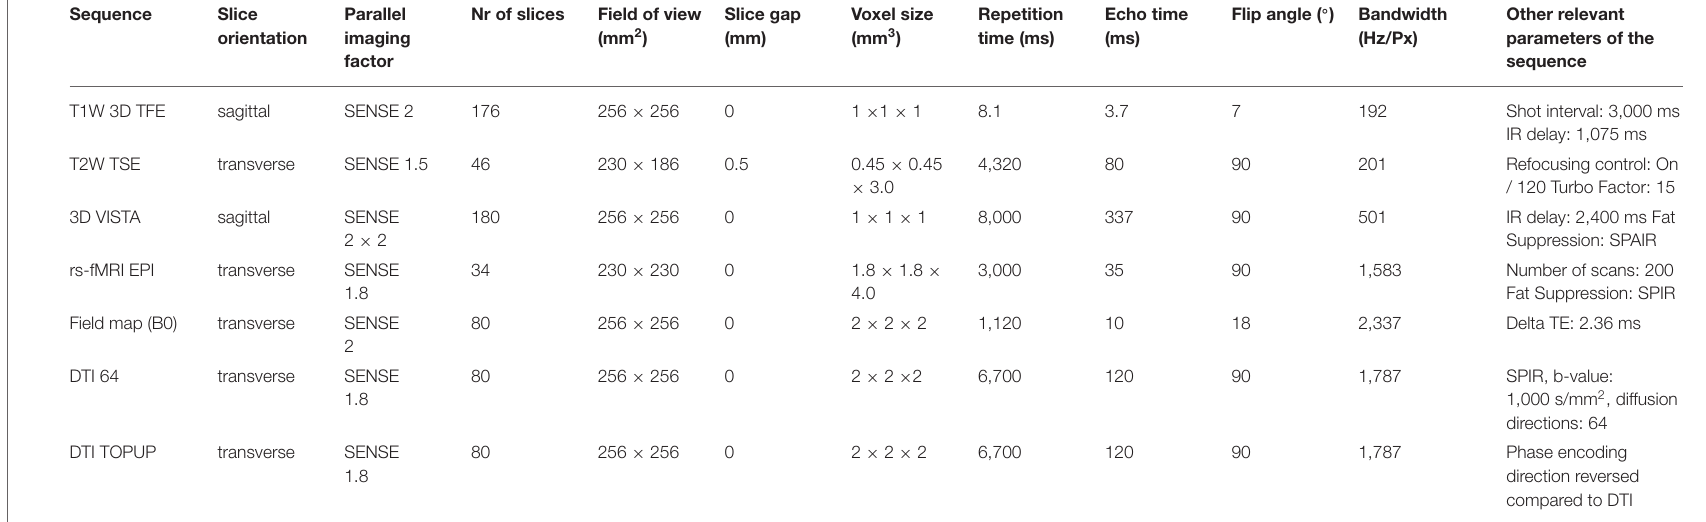
TABLE 1 | Used MRI sequences using Philips Ingenuity 3.0T TF PET-MR (Philips Healthcare, Amsterdam, the Netherlands). Sequence